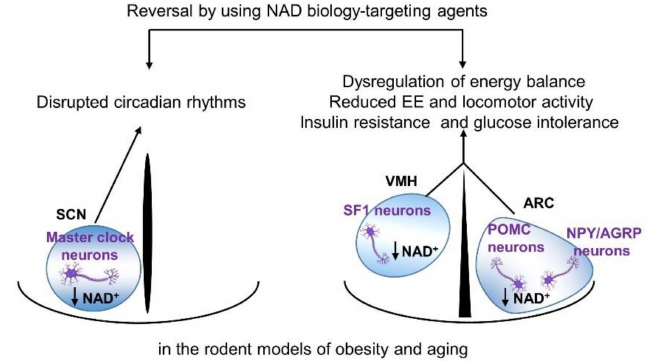
Figure 1. Altered NAD + biology in the hypothalamic neurons leads to the disruption of energy / glucose metabolismandcircadianrhythmsobservedinobeseoragedhumansandrodents. AGRP: Agouti -related protein, ARC: arcuate nucleus, NAD + : nicotinamide adenine dinucleotide, NPY: neuropeptide Y, POMC: proopiomelanocortin, SCN: suprachiasmatic nucleus, SF1: steroidogenic factor-1, and VMH: ventromedial